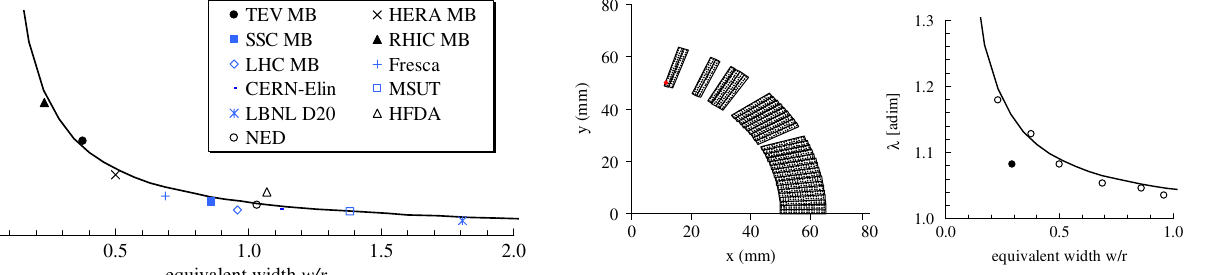
FIG. 14. (Color) Ratio (cid:7) between peak field and current density vs equivalent ratio width/aperture radius as defined in Eq. (23): analytical fit of Eq. (18) (solid line) and values for 11 dipoles evaluated without iron (markers).